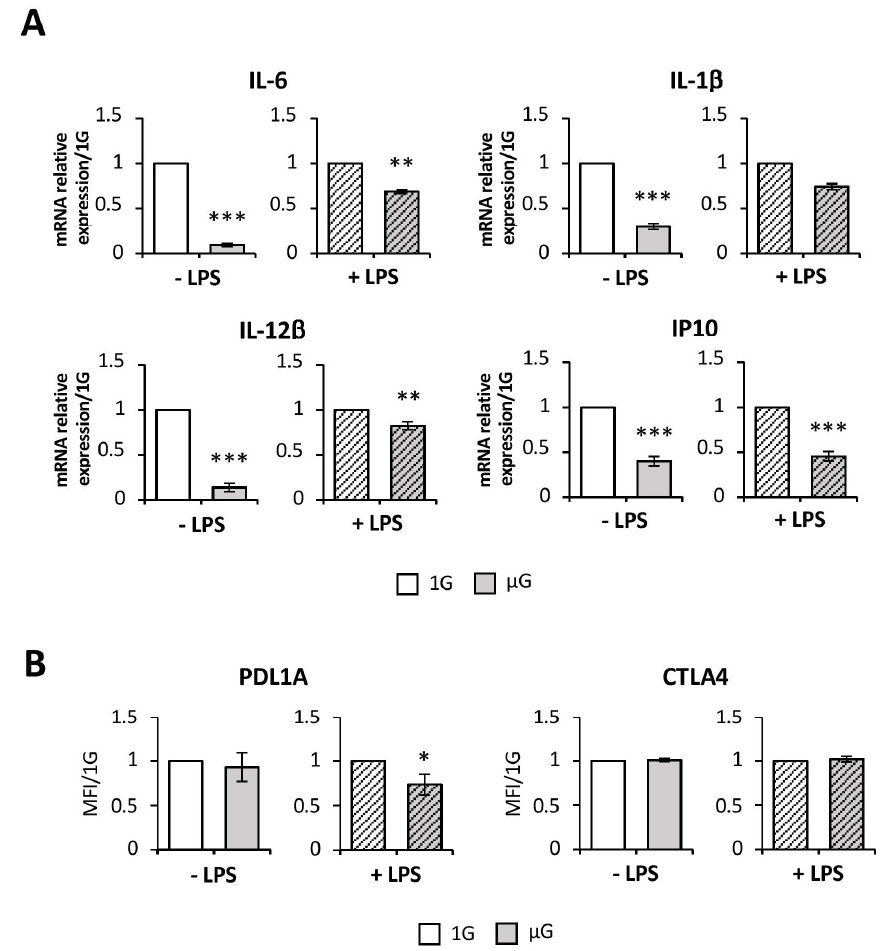
Figure 3. Simulated microgravity impairs pro-inflammatory cytokine production but does not increase tolerance makers in Flt3-L-differentiated BMDC. Mouse BMDCs were differentiated for 7 days with Flt3-L followed by 24 h in the absence (1G) or presence (µG) of simulated microgravity with (+LPS) or without ( − LPS) LPS. ( A ) mRNA quantification of the indicated genes was performed by real-time PCR. Wild-type values were normalized to a value of 1. ( B ) Cells were analyzed by flow cytometry for the expression of PDL1A and CTLA4 in CD11C+ populations. Mean MFI ± SEM with 1G values were normalized to a value of 1. Data from three ( A ) or four ( B ) independent experiments were normalized and are expressed as fold differences relative to 1G cells. t -test or Mann–Whitney test was used to reveal statistically significant differences. * p < 0.05; ** p < 0.01; *** p <